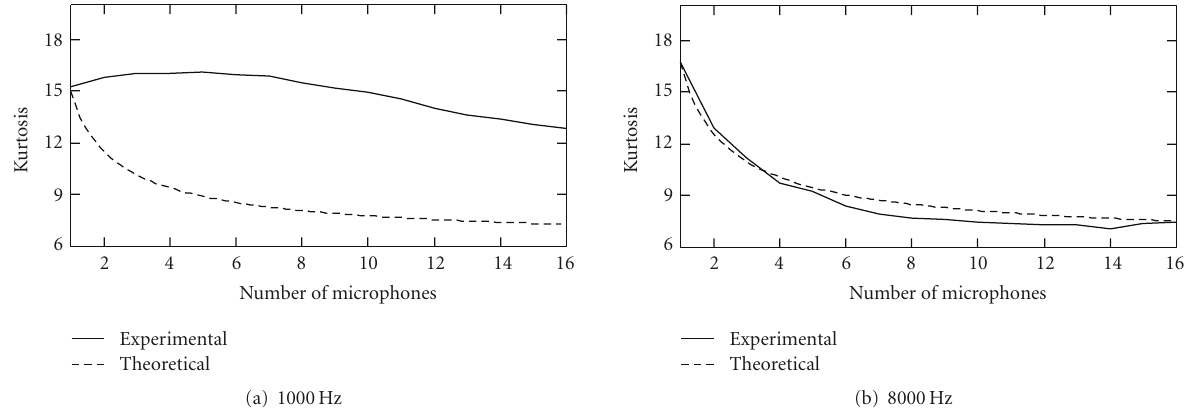
Figure 8: Simulation result for noise with interchannel correlation (solid line) and theoretical e ff ect of DS assuming no interchannel correlation (broken line) in each frequency subband.